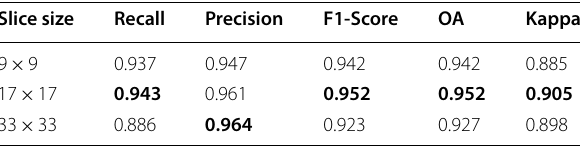
Table 6 Evaluation of the proposed model with the